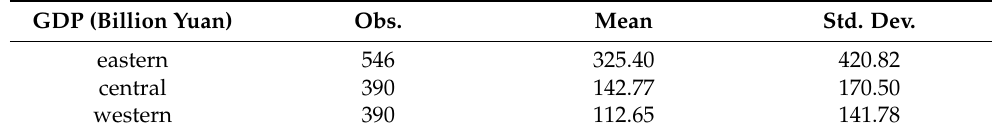
Table 6. GDP of the eastern, central and western regions.